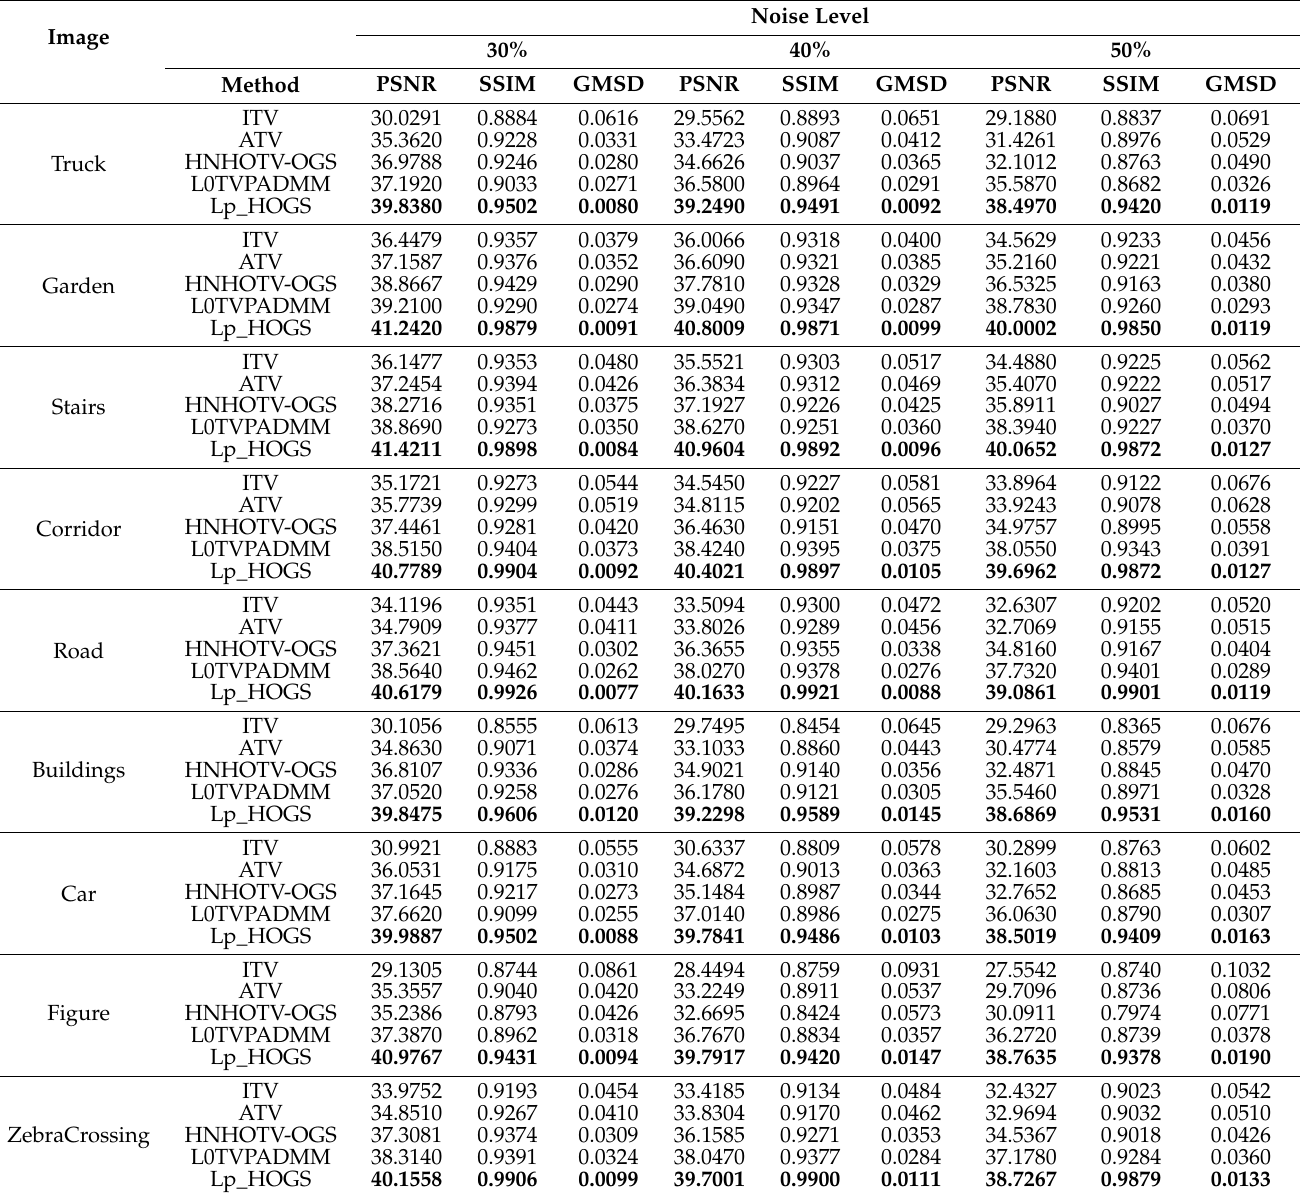
Table 4. The deblurring effects of Lp_HOGS and the other methods on the images with a 7 × 7 Gaussian blur. The optimal indicators under each condition are denoted in bold.